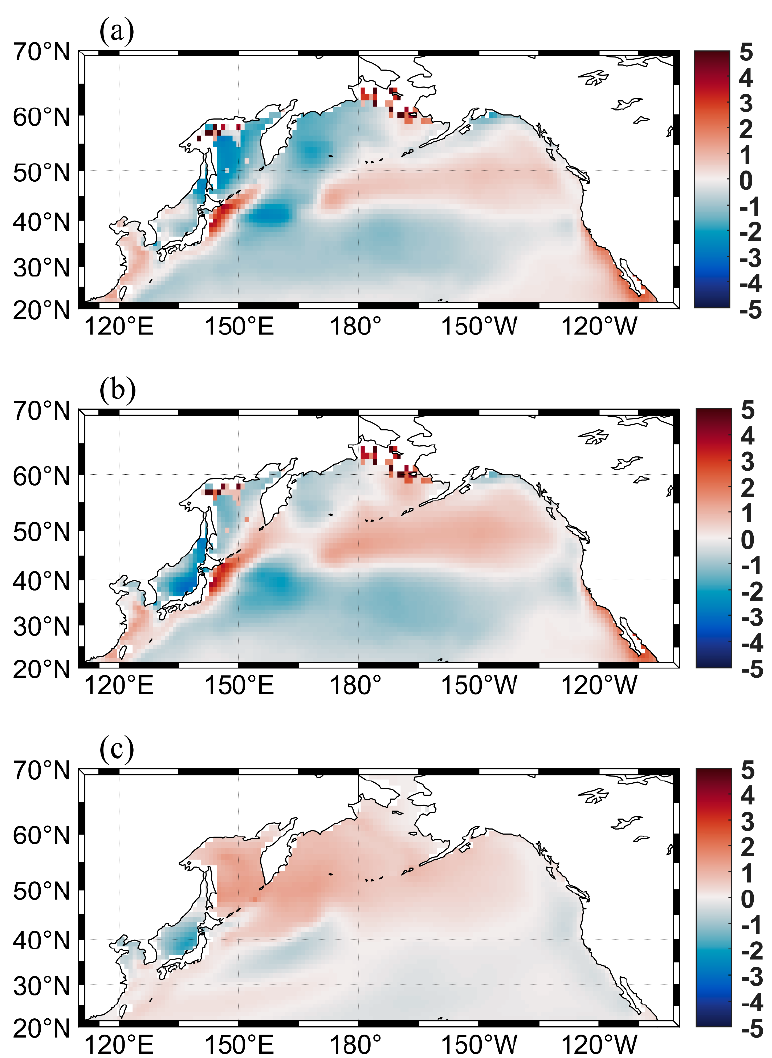
Figure 8. Spatial patterns of SSTA biases in north Pacific (units: ◦ C) between the predictions and observation: ( a ) original FIO − ESM − CPS results, ( b ) modified FIO − ESM − CPS results, and ( c ) the difference of bias between modified and original FIO-ESM-CPS at 1-year lead